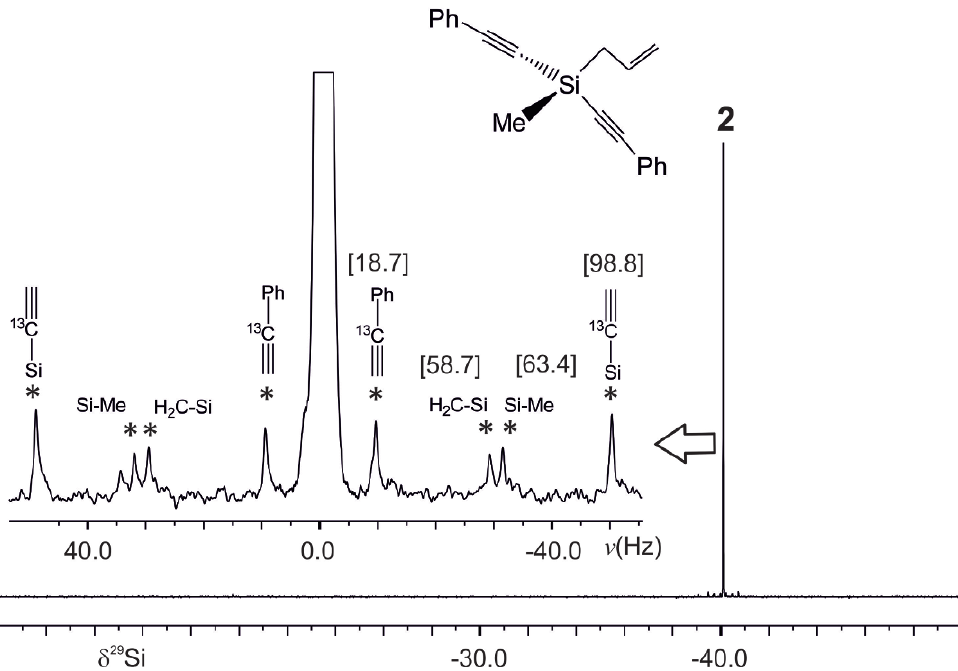
Figure 1. 79.4 MHz 29 Si{ 1 H} NMR spectrum of